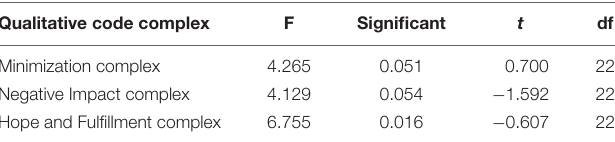
TABLE 2 | Significant Qualitative Code complex mean frequency differences between CSA/USE and USE